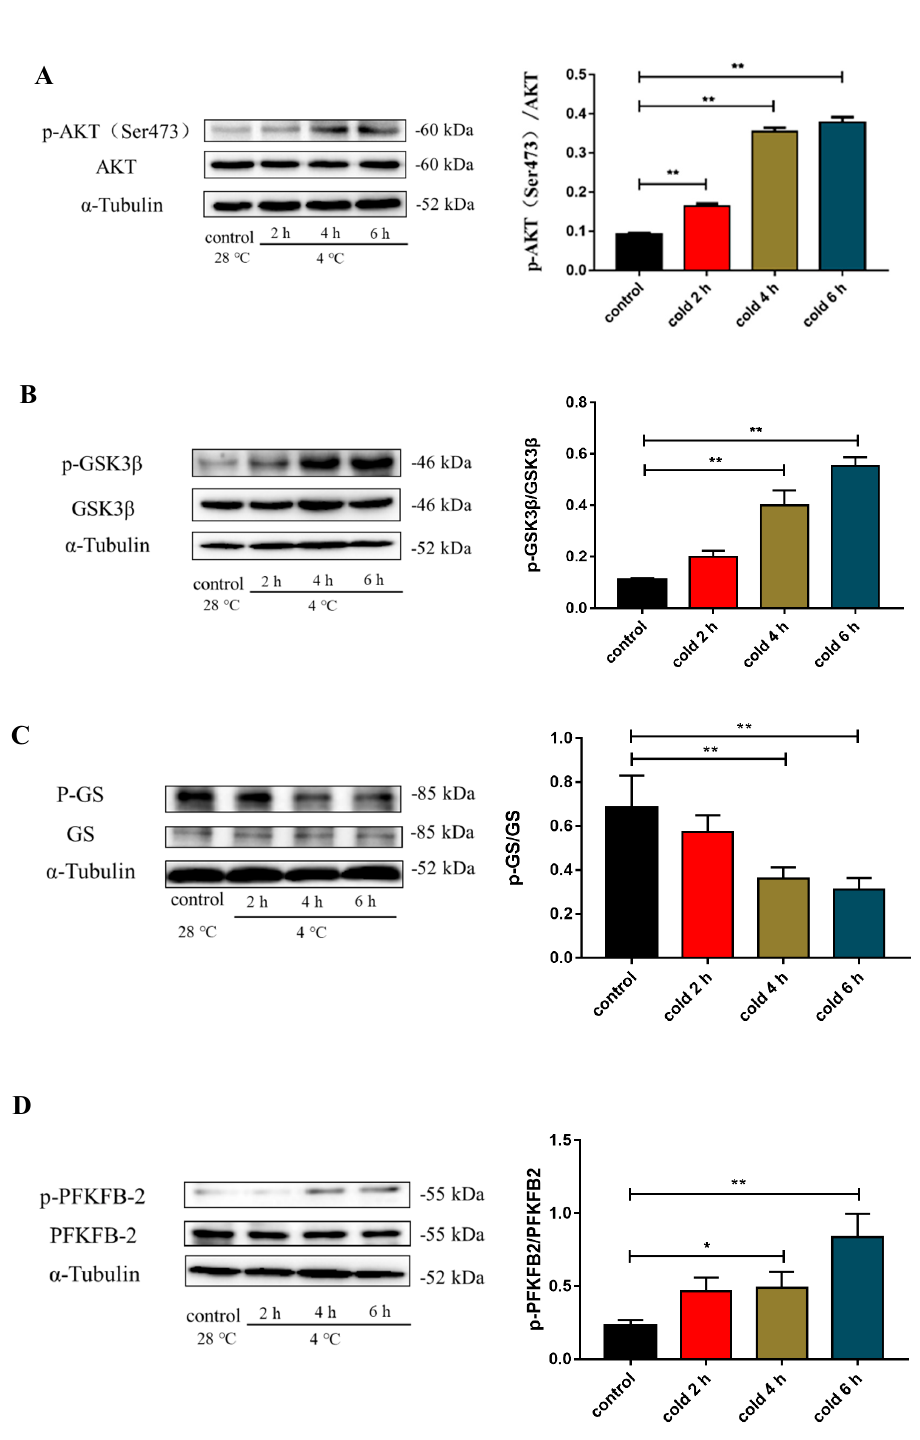
Figure 6. Effect of acute cold exposure on glucose metabolism in C57BL/6 mouse livers. ( A ) The level of protein kinase B (AKT) protein and phosphorylation status (Thr308) in the liver; ( B ) the level of glycogen synthase kinase-3 β (GSK3 β ) protein and phosphorylation status (Ser9) in the liver; ( C ) the level of glycogen synthase (GS) protein and phosphorylation status (Ser641) in the liver; ( D ) the level of 6-phosphofructo-2-kinase/fructose-2,6-biphosphatase 2 (PFKFB2) protein and phosphorylation status (Ser483) in the liver. The data are presented as the mean ± SEM ( n = 8). Statistically significant differences are indicated; * p < 0.05 and ** p <